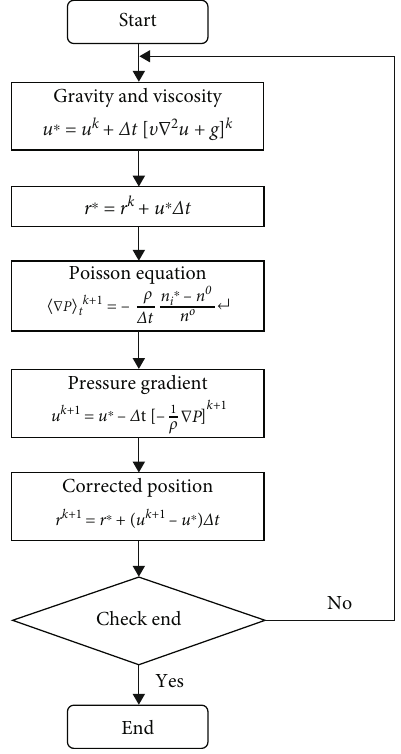
Figure 2: Flow chart of the MPS